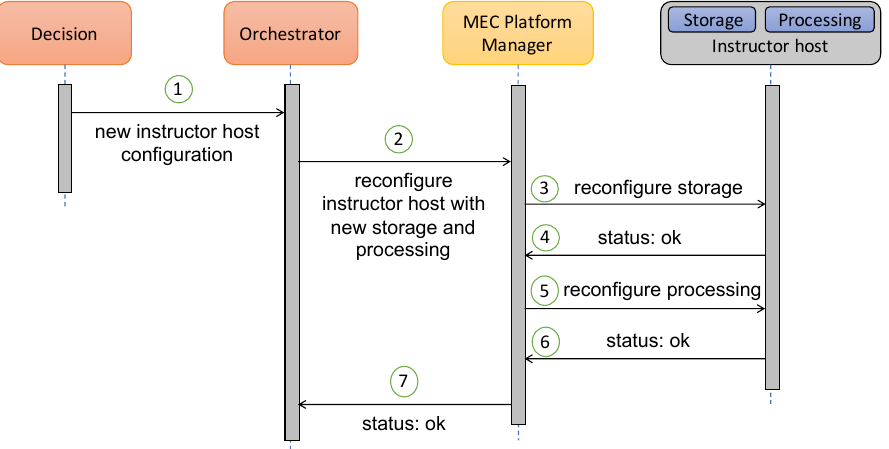
Figure 2. Architecture reconfiguring two MEC Apps running on top of an MEC